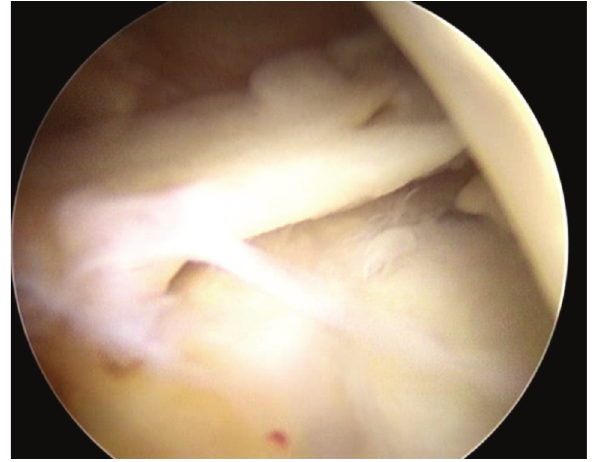
Arthroscopic image showing implant rupture in the Fig. 1b: posterior horn of the medial meniscus.